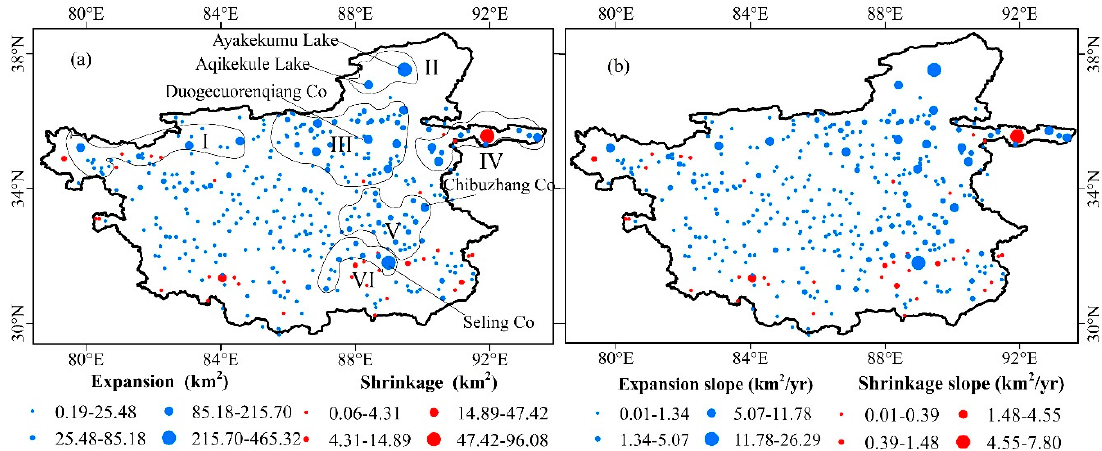
Figure 3. Spatial patterns of trends in lake-area change ( a ) and change rate ( b ) from 2000 to 2017 in the endorheic basin. The black line contour is the Qinghai–Tibet Plateau (QTP) endorheic basin; the blue dots mean lake expansion and red dots mean lake shrinkage.